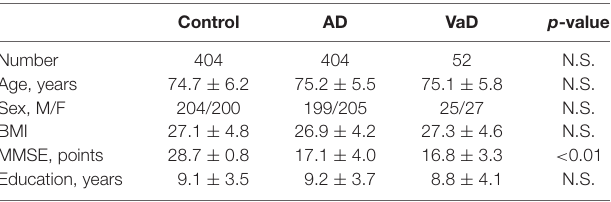
TABLE 1 | Demographics characteristics of the study